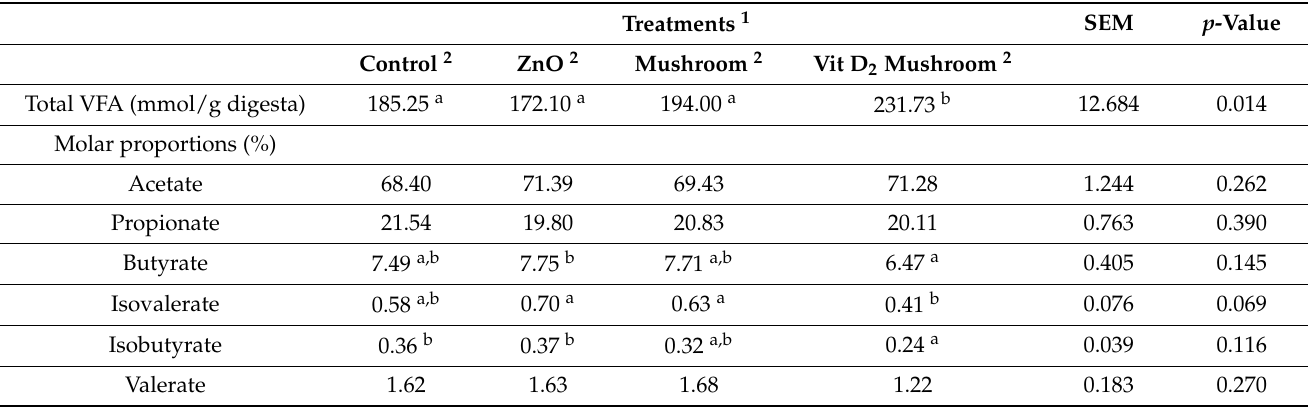
Table 9. The effect of dietary treatment on the total concentrations and molar proportions of VFA in the colon (least-square means with their standard